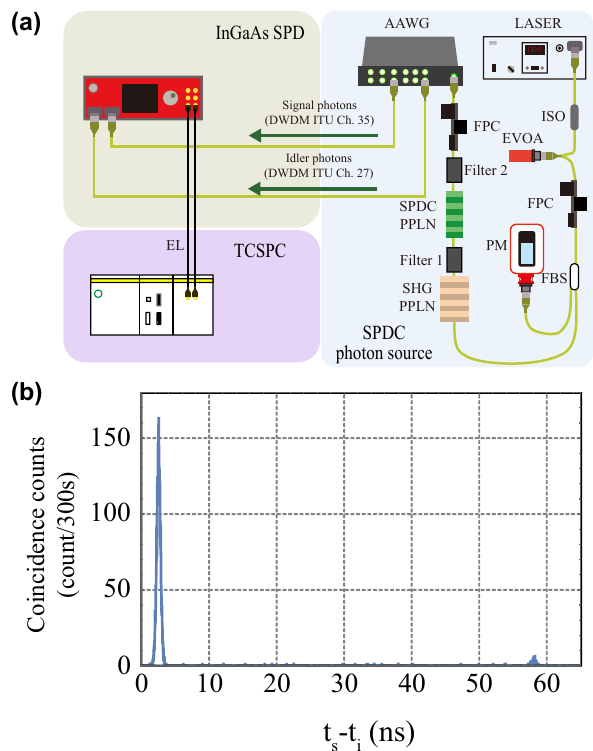
Figure 8: (a) Schematic optical setup diagram to define the InGaAs single-photon detector (SPD) detection efficiency with the time-correlated single photon counting (TCSPC). (b) Spontaneous parametric down-conversion photon-pair correlation measurement represents signal (idler) photon detection time. result, where t s(i) LASER: pulsed LASER, EVOA: electrical variable optical attenuator, AAWG: athermal arrayed waveguide grating, SPDC PPLN: spontaneous parametric down-conversion PPLN (waveguide), SHG PPLN: second-harmonic generation PPLN (bulk), filter 1: 1550 nm block filter, filter 2: 775 nm block filter, EL: electric line.